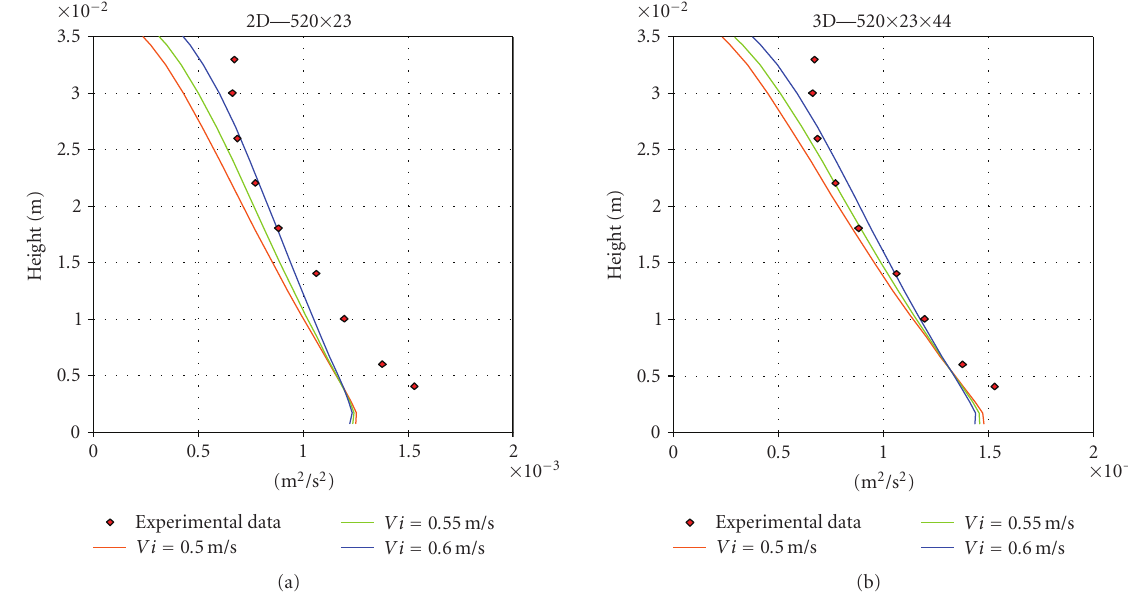
Figure 5: Water turbulent kinetic energy: (a) two-dimensional simulations; (b) three-dimensional